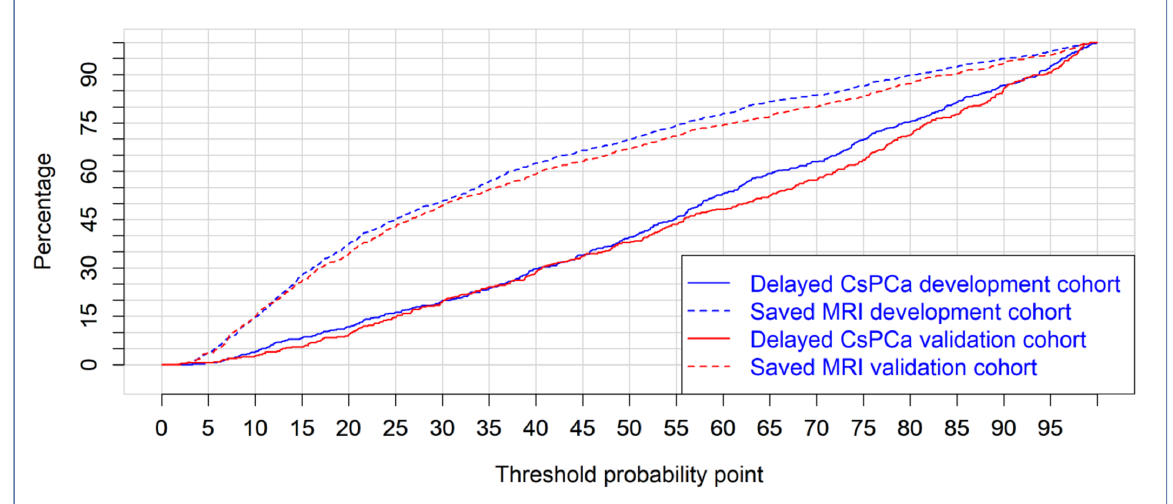
Figure 5. Saved mpMRI scans and missed csPCa for a continuous risk threshold of csPCa, represented through clinical utility curves.